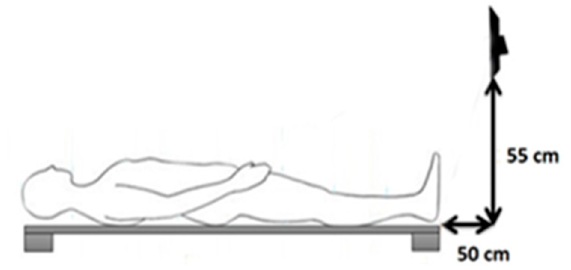
Figure 4. Illustration of the system in the experiment [43].